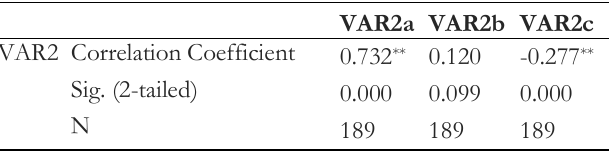
Table 4. Correlation among neutrosophic item 2 and classical item 2.